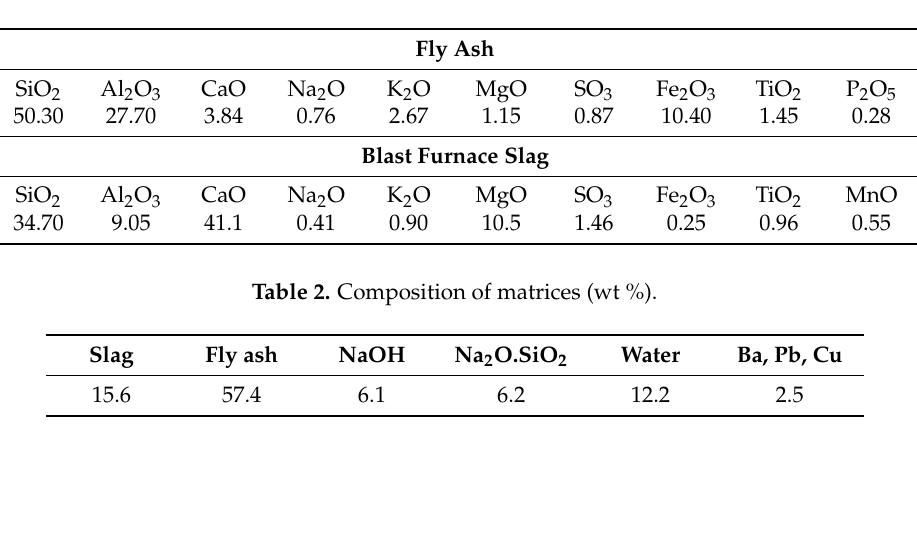
Table 1. Chemical composition of fly ash and BFS (wt %).